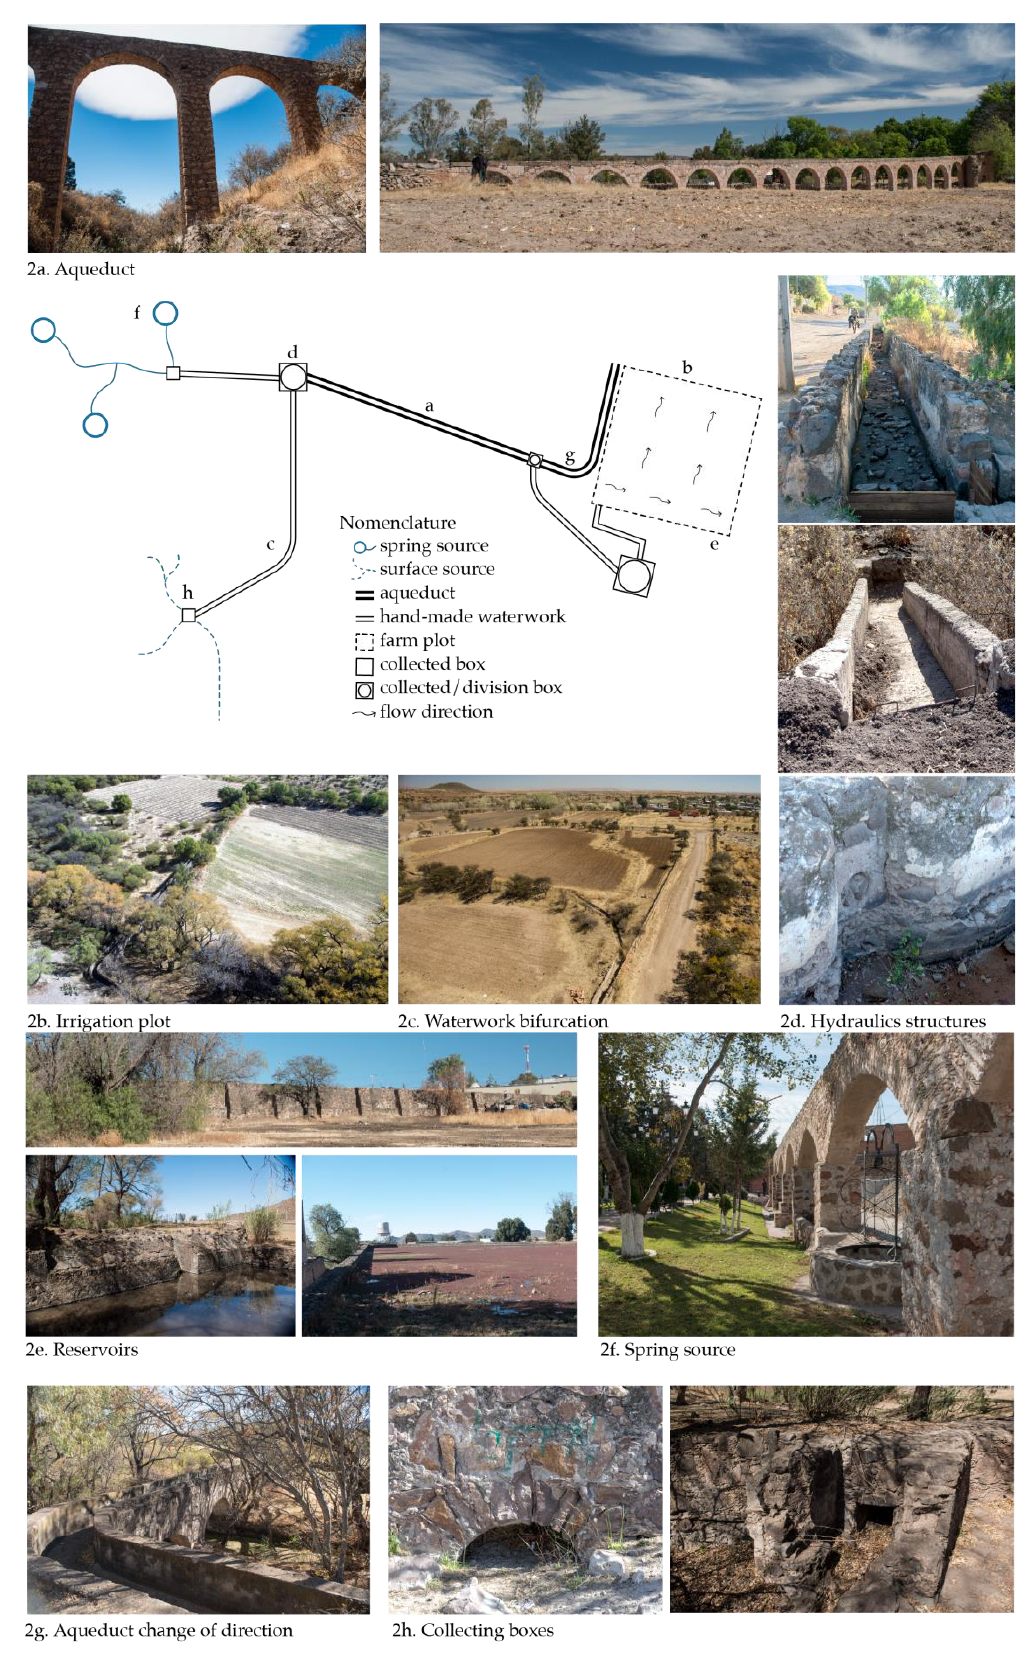
Figure 2. Schematic representation of agricultural systems (elaborated by authors with photographs taken by